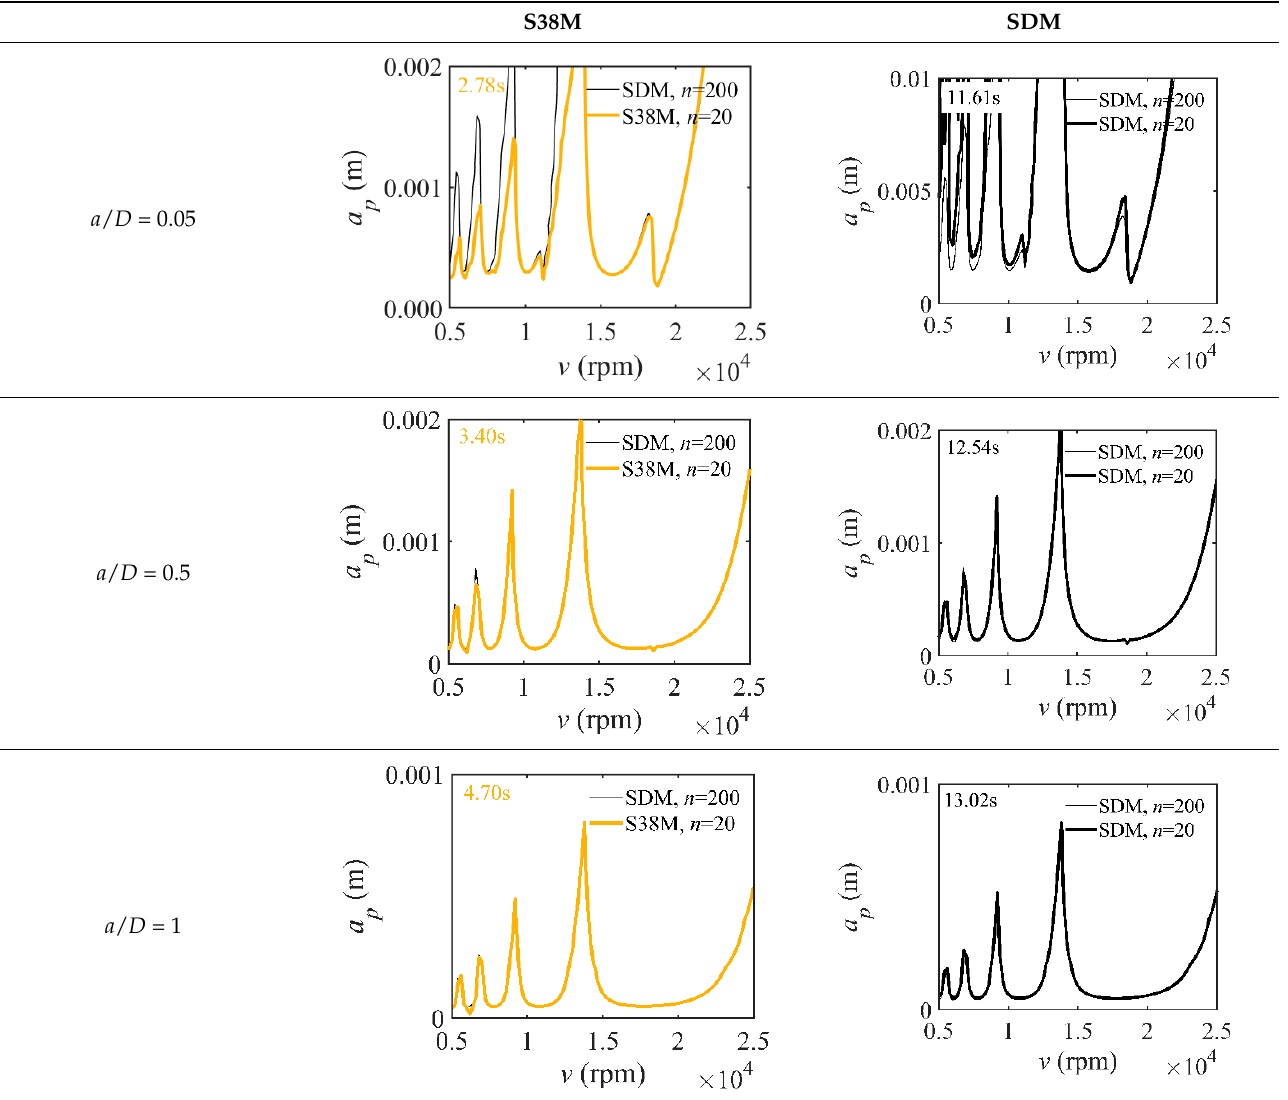
Table 5. Comparisons of S38M and SDM for the two-DOF milling model.